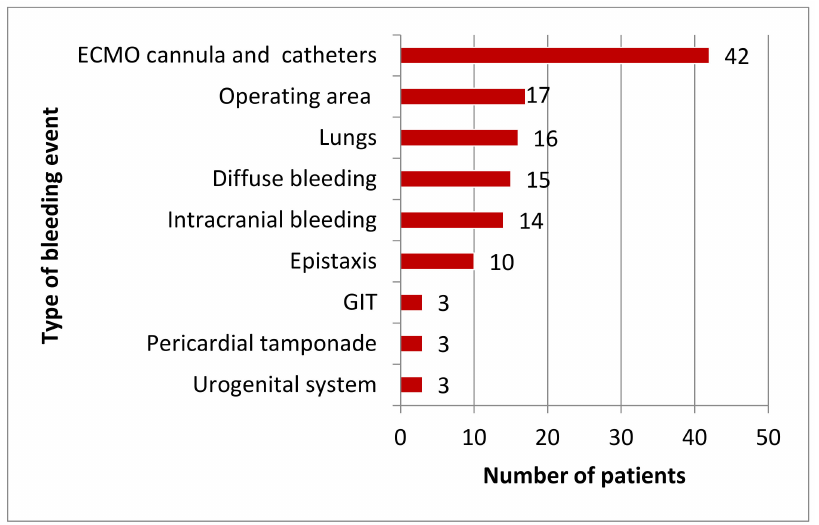
Figure 1. Type of bleeding event in patients receiving ECMO support ( n = 123). ECMO: extracorporeal membrane oxygenation; GIT: gastrointestinal tract.